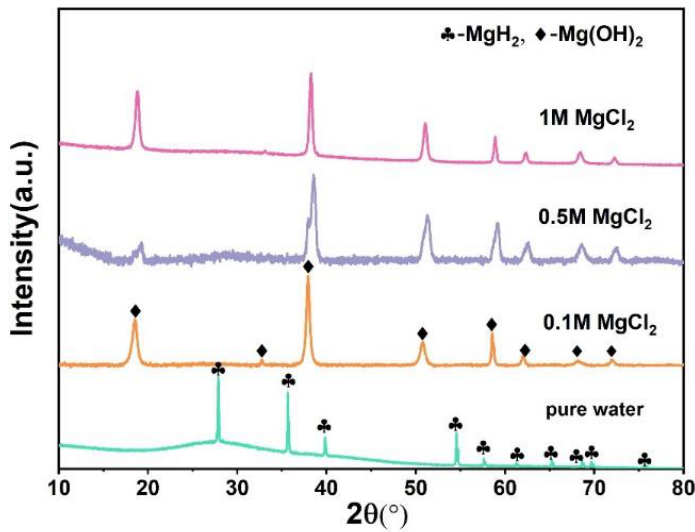
Figure 3. XRD patterns of the hydrolysis by-products of MgH 2 − 3wt %LiH-G in the different concen- trations of MgCl 2 aqueous solution.